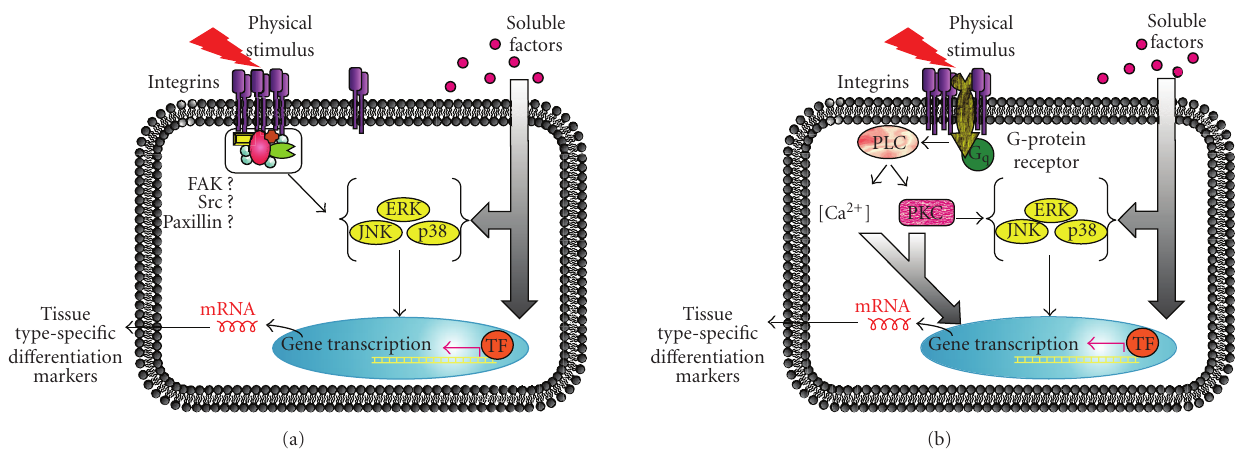
Figure 3: Two alternate coupling molecular mechanisms. The soluble factors are known to play an important role in stem cells di ff erentiation (thicker arrows). (a) A physical stimulus may a ff ect cell di ff erentiation synergistically in the presence of the soluble factors via integrins and the MAP kinase signaling system. The physical stimulus causes integrin redistribution, clustering, activation, and assembly of some focal adhesion proteins such as FAK, paxillin, vinculin, src, and others. Enzymatic activity of assembled proteins (e.g., FAK or src) causes further MAP kinase activation. In e ff ect, the MAP kinase cascade is amplified and cell di ff erentiation may be accelerated. (b) Alternative mechanism involves activation of other receptors (e.g., G-proteins receptors) in the cell membrane. This leads to the PLC enzyme-mediated signaling through Ca 2+ and protein kinase C (PKC) in multiple pathways. Not all intricate signaling e ff ects of these secondary messengers are shown. However, PKC activation can be e ff ectively coupled to the MAP kinase